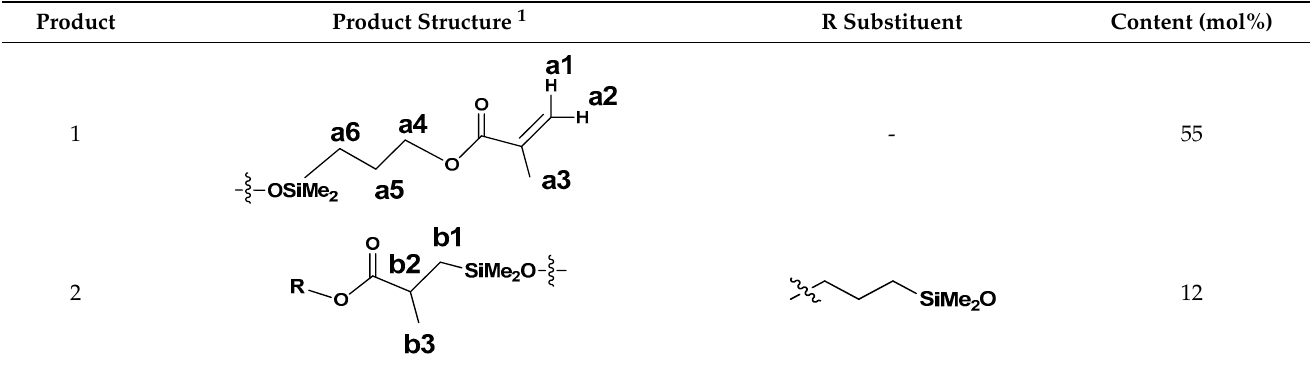
Table 2. Chemo- and regioselectivity of the allyl methacrylate hydrosilylation with SS-H.